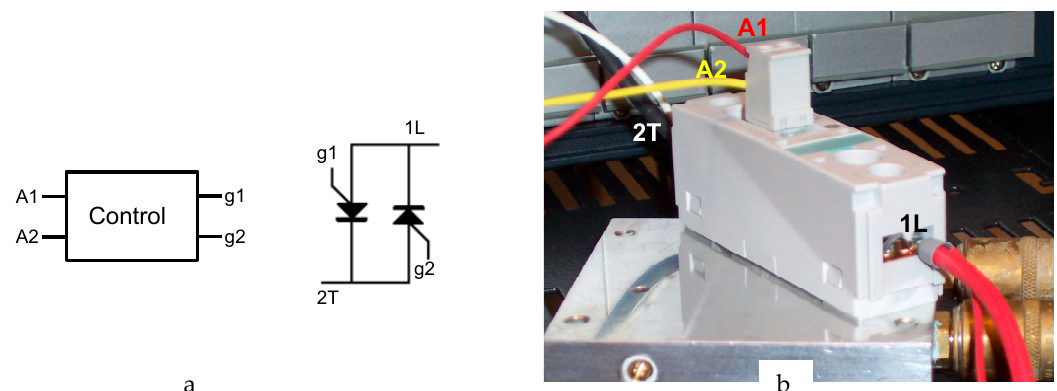
Figure 2. ( a ) Schematic of the solid state relay module; ( b ) sample on cold plate, with leads attached.